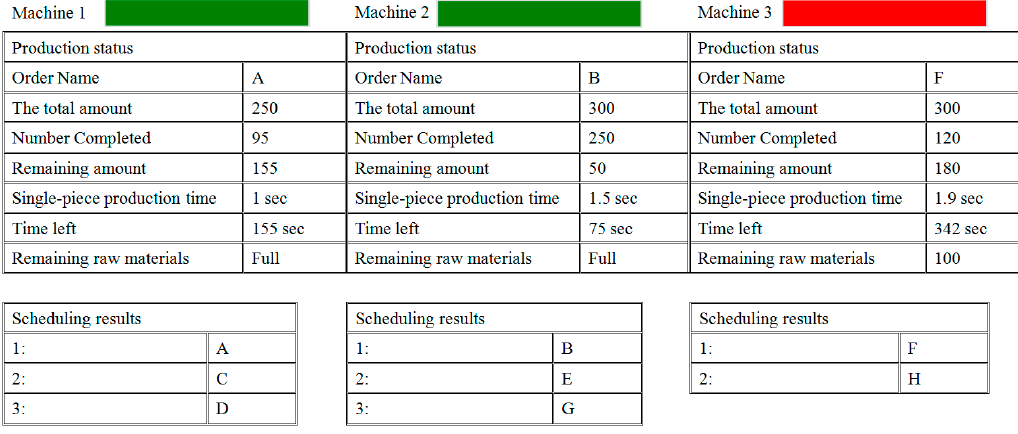
Figure 8. Machine operating data integrated on web page.